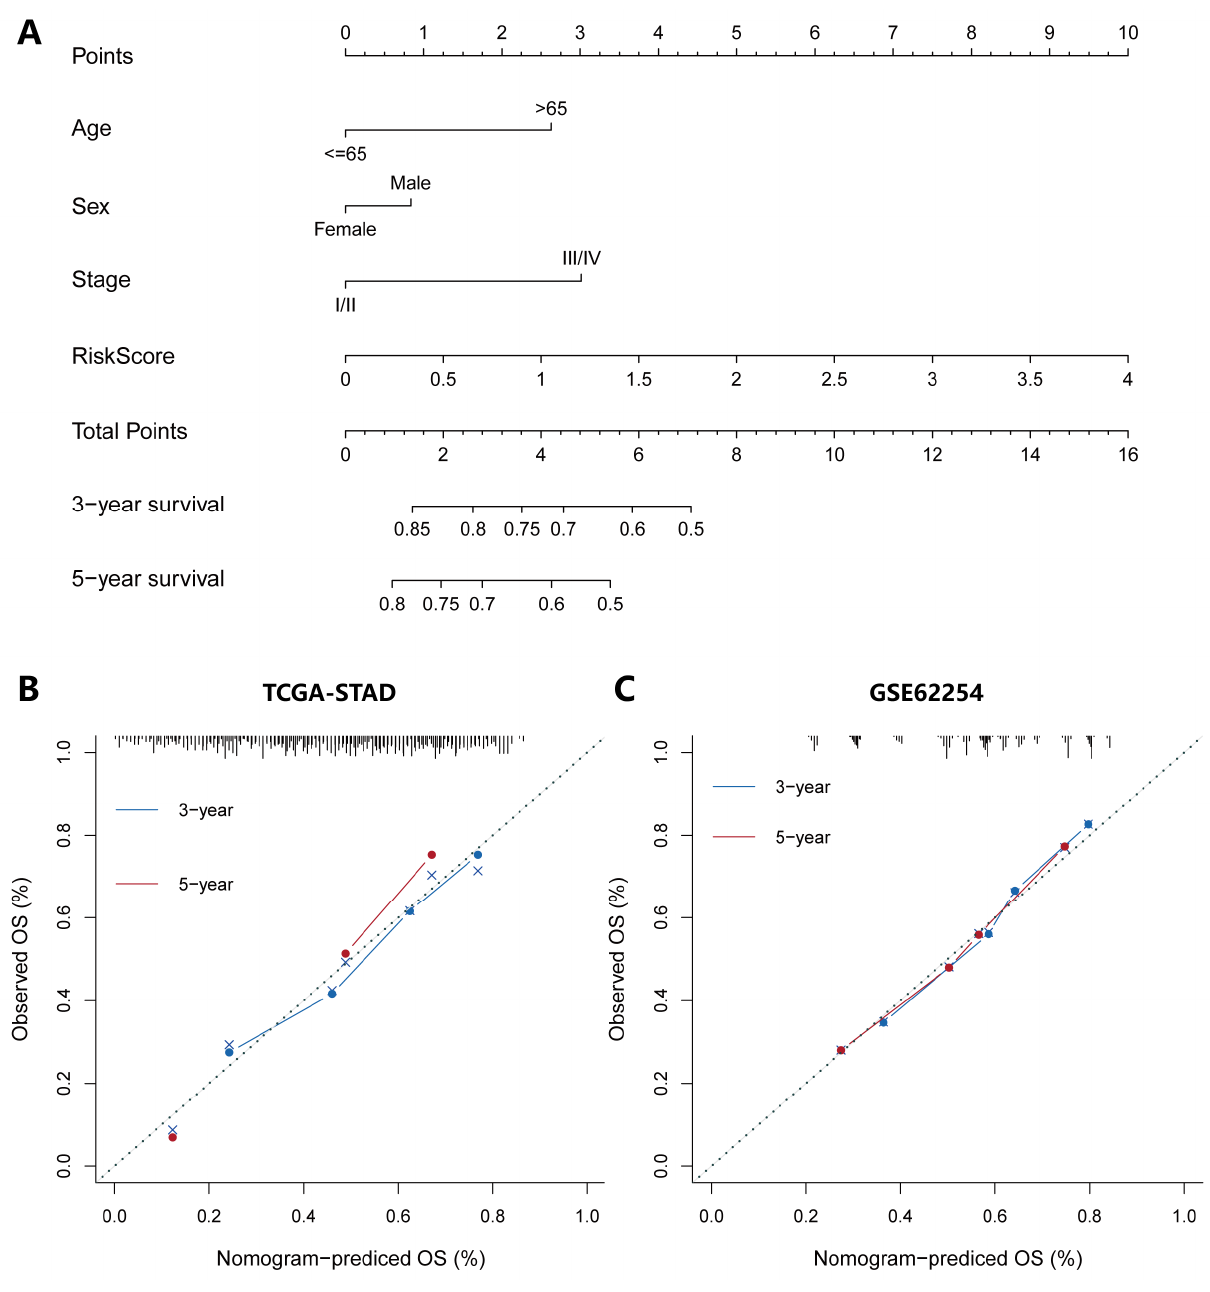
Figure 6. Construction and evaluation of a nomogram based on the IRS to predict the 3-year and 5-year OS for patients with gastric cancer. ( A ) Nomogram was constructed with the TCGA-STAD cohort for predicting the probability of 3-year and 5-year OS for GC patients. ( B ) Calibration plot for 3-year and 5-year OS in the TCGA-STAD cohort. ( C ) Calibration plot for 3-year and 5-year OS in the GSE62254 cohort.